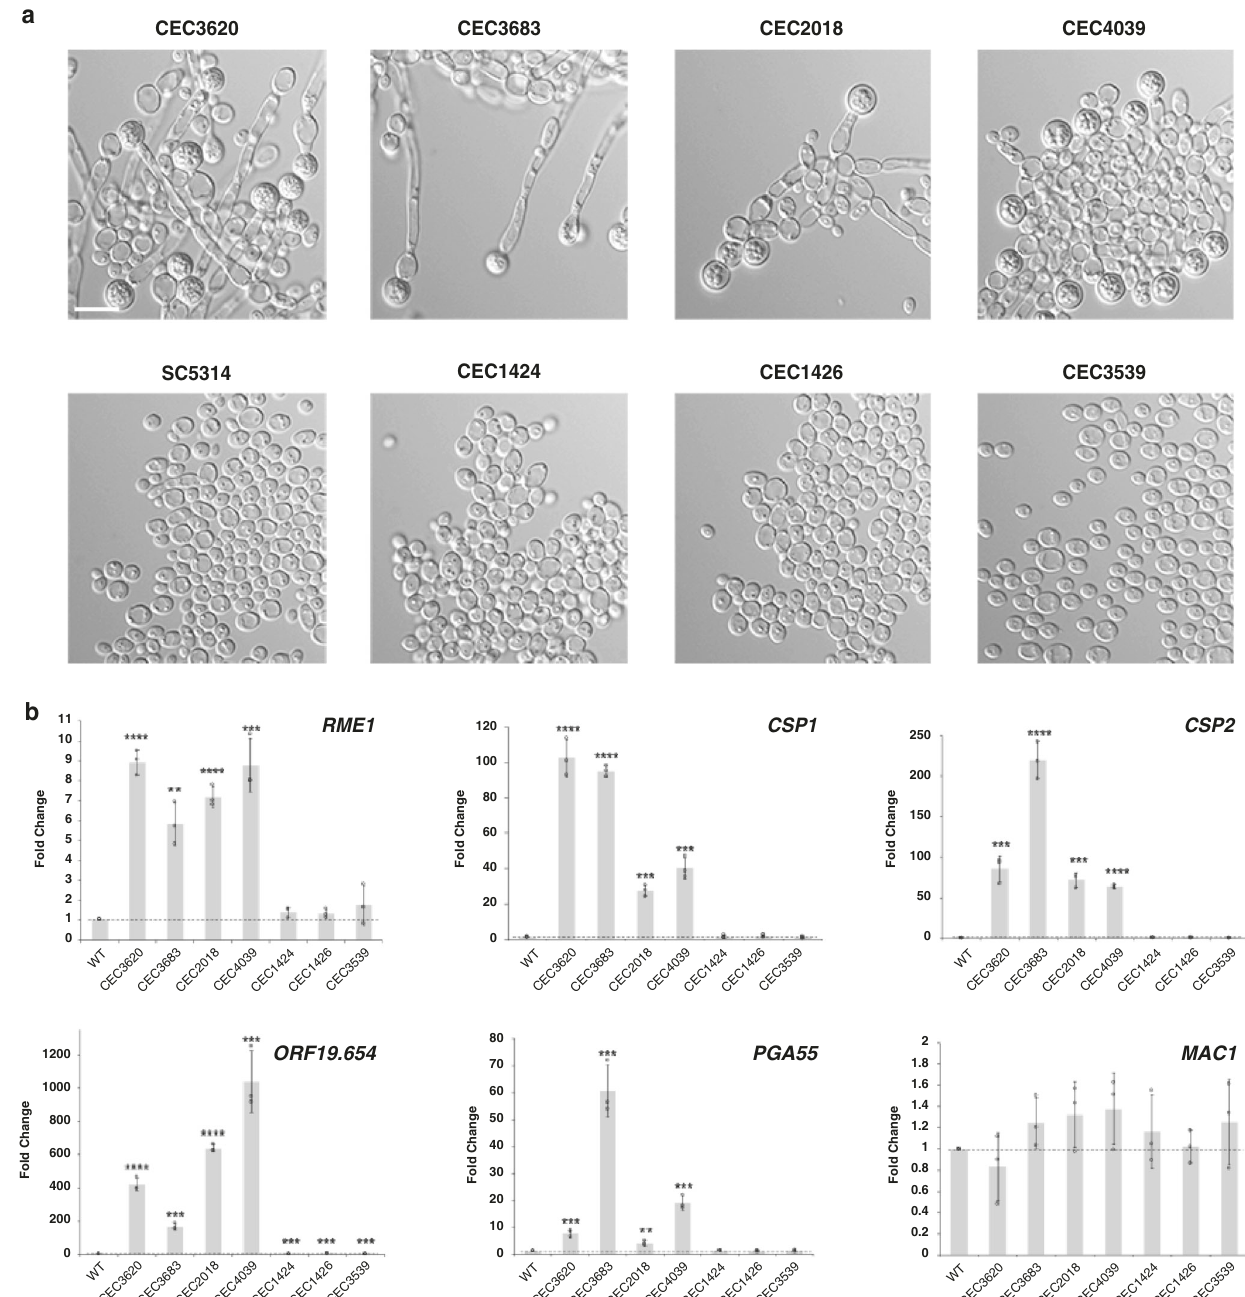
Fig. 3 Expression levels of RME1 and its targets are related to the capacity to form chlamydospores in C. albicans strains. a Clinical isolates of C. albicans exhibit differences in chlamydospore formation ef fi ciency. The upper panel shows strains that formed masses of chlamydospores when grown in liquid PCB at 25 °C for 24 h, whilst the bottom panel shows strains defective for chlamydospore formation under the tested conditions. WT SC5314 strain was used as reference for comparison. Scale bar = 10 μ m. b Expression levels of RME1 ( P = 0.000022; 0.001395; 0.000035; 0.00062; 0.058885; 0.083474; 0.275589), CSP1 ( P = 0.000074; <0.000001; 0.000126; 0.000357; 0.71581; 0.156621; 0.221736), CSP2 ( P = 0.000797; 0.000078; 0.000163; 0.000001; 0.848682; 0.388113; 0.130289), ORF19.654 ( P = 0.000047; 0.000104; <0.000001; 0.00062; 0.000517; 0.000496; 0.000658), PGA55 ( P = 0.000905; 0.000443; 0.005717; 0.000285; 0.092887; 0.52506; 0.330046) and MAC1 (control) were quanti fi ed by RT - qPCR in C. albicans strains and normalized against SC5314 values. Data are expressed as the mean ± SD, n = 3 biological replicates, over three experiments. * P < 0.05; ** P < 0.01; *** P < 0.001; **** P < upregulated only upon RME1 overexpression (either involved in We compared the list of genes that are positively regulated by carbohydrate metabolic processes or encoding cell wall-associated Rme1 in P TET - RME1 transcriptomics data to those downregu- lated in CEC2018- rme1 ΔΔ data. We found an overlap of 58 genes, proteins), suggesting that Rme1 could regulate other cellular many of which are involved in chlamydospore formation and processes besides chlamydosporulation when C. albicans is grown fi lamentation (Fig. 4b, c). Interestingly, many genes were under conditions not conducive to chlamydospore formation.